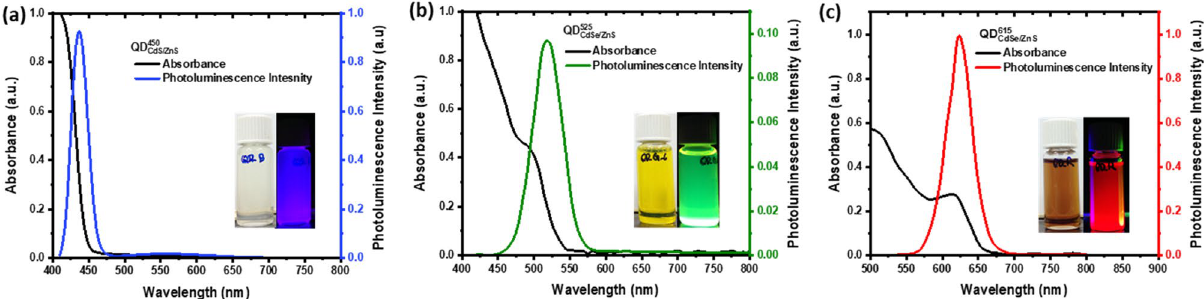
Figure 3. UV–Visible absorbance and fluorescence spectrum of Quantum dots dispersed in n-Hexanes ( a ) QD 450 CdS / ZnS showing fluorescence at 450 nm and strong absorbance 410 nm, insight shows the blue fluorescence 525 ( b ) QD CdSe / ZnS showing fluorescence at 525 nm and strong absorbance 480 nm, insight shows the green 615 fluorescence ( c ) QD CdSe / ZnS showing fluorescence at 615 nm and strong absorbance 580 nm, insight shows the red fluorescence.